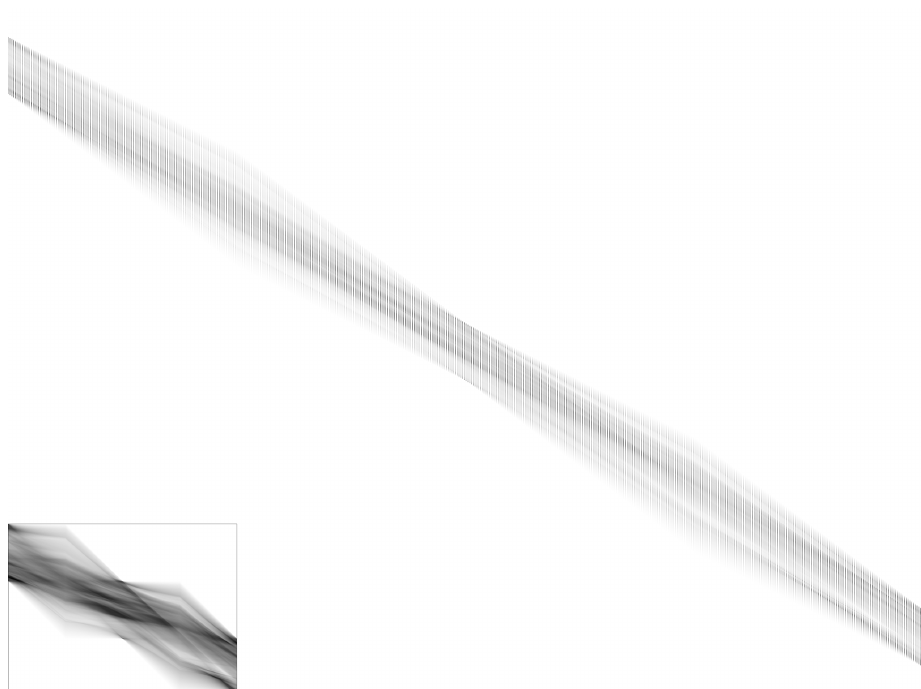
Figure 4. Extended DRT and original DRT, shown inserted on lower left